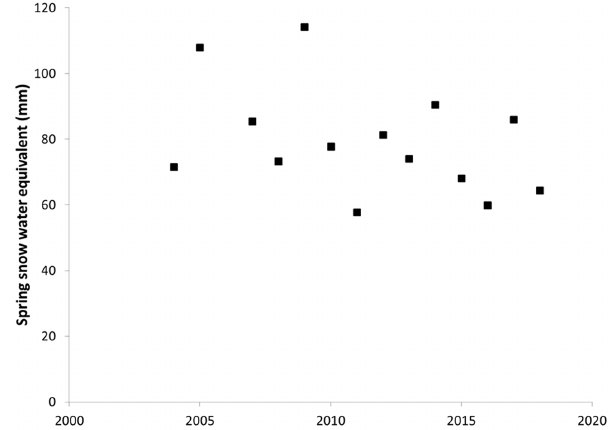
Figure 10. Basin average spring maximum snow water equivalent in